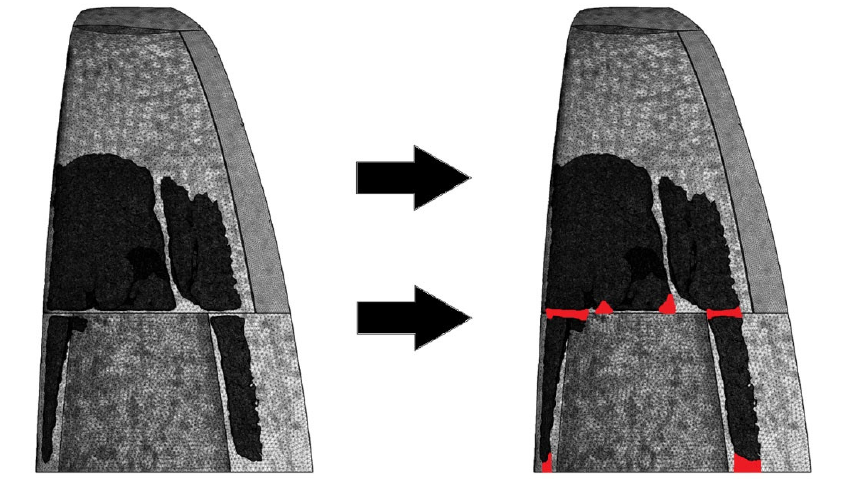
Figure 14. Indicative resin drainage scheme. Dark areas indicate hollow internal structure. Red markings indicate areas where further material removal is required for liquid resin drainage after 3D